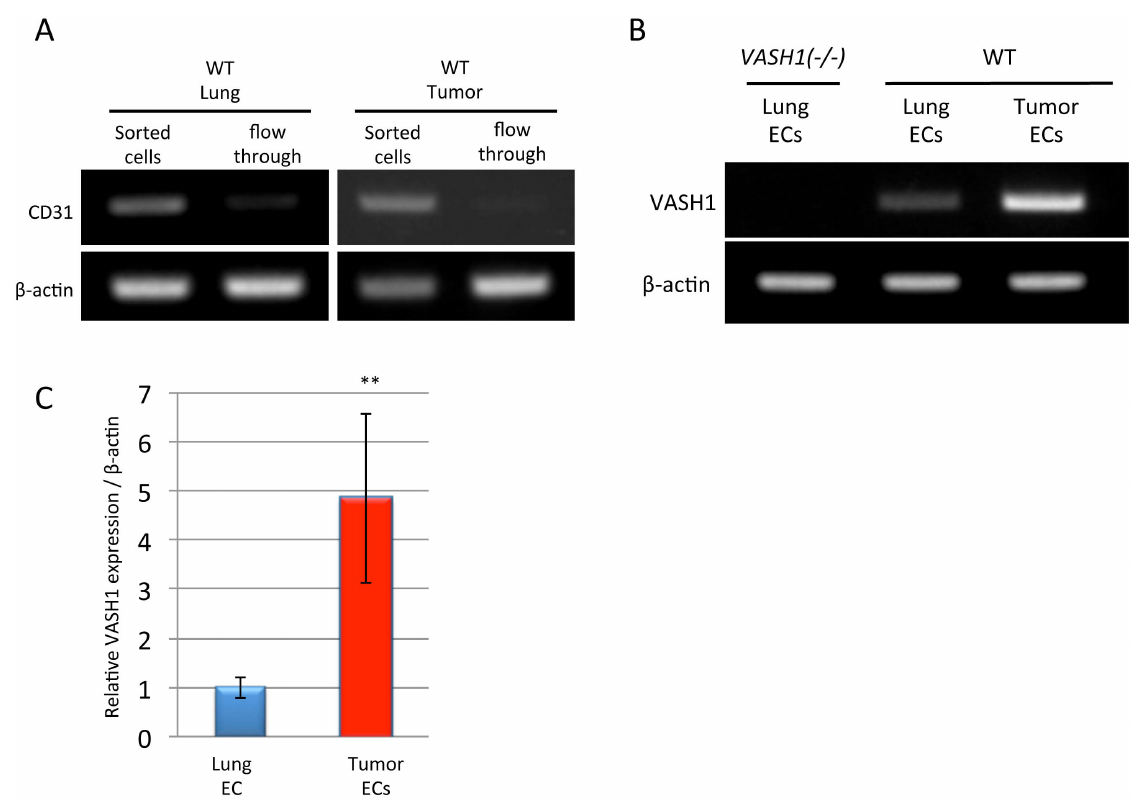
Figure 2. Expression of VASH1 in ECs. A: The expression of CD31 expression in magnetically sorted cells from normal lungs or tumor tissues and flow through fraction was analyzed by RT-PCR. B: The expression of mouse VASH1 in lungs from VASH1( 2 / 2 ) mice, and in normal lungs and tumor tissues from WT mice were determined by RT-PCR. C: The expression of mouse VASH1 expression in normal lungs and tumor tissues from WT mice was quantitated by real-time RT-PCR and compared (N=3). **p , 0.01.